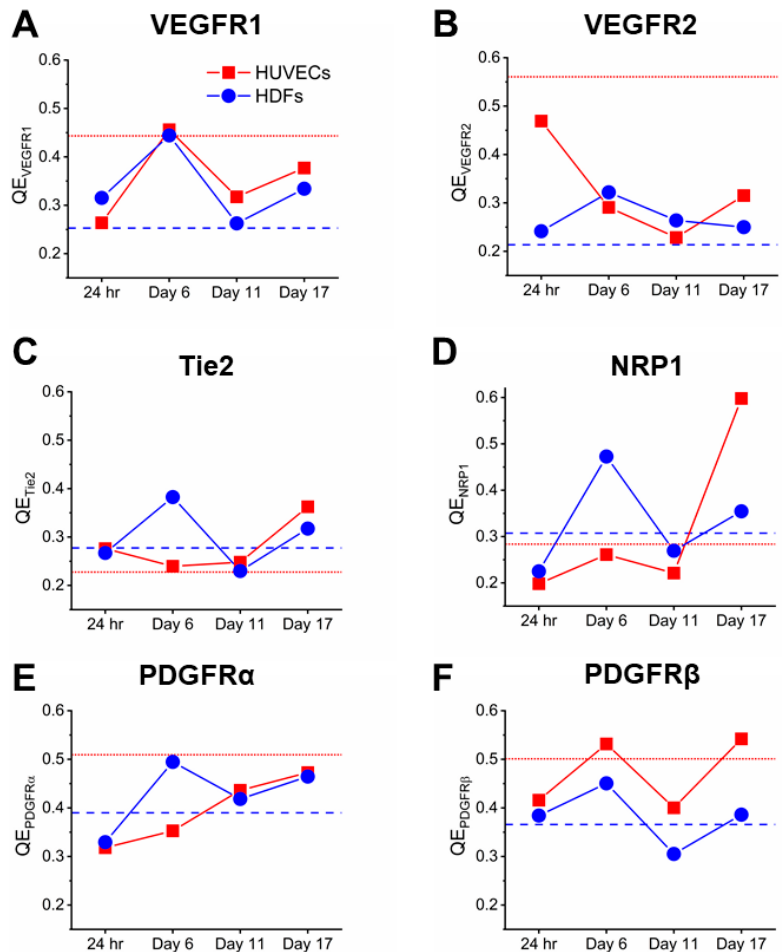
Figure 4. Quadratic entropy (QE) of co-cultured HUVECs and HDFs up to 17 days. We showed QE of ( A ) VEGFR1, ( B ) VEGFR2, ( C ) Tie2, ( D ) NRP1, ( E ) PDGFR α , and ( F ) PDGFR β on HUVECs and HDFs from 24-h, 6-day, 11-day, and 17-day co-cultures. Dashed lines represent receptor concentrations of collagenase-treated monocultures. Red: HUVECs; Blue: HDFs.